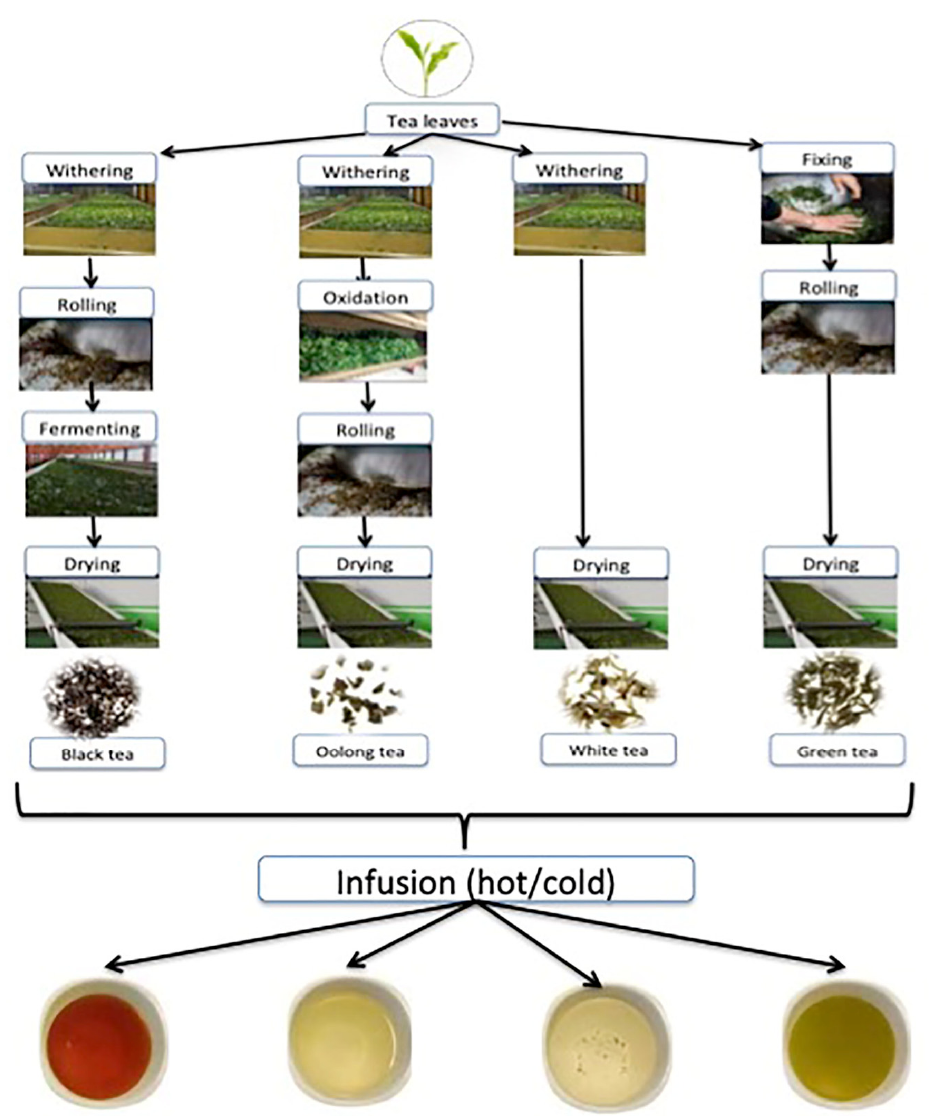
Figure 1. The manufacturing process steps of tea production. Western countries, especially those in Europe, the United Kingdom, and the United States, consume black tea [18], whereas Far-Eastern countries, especially Japan, Korea, and Northern China consume green tea [19]. Besides, southern China and Taiwan